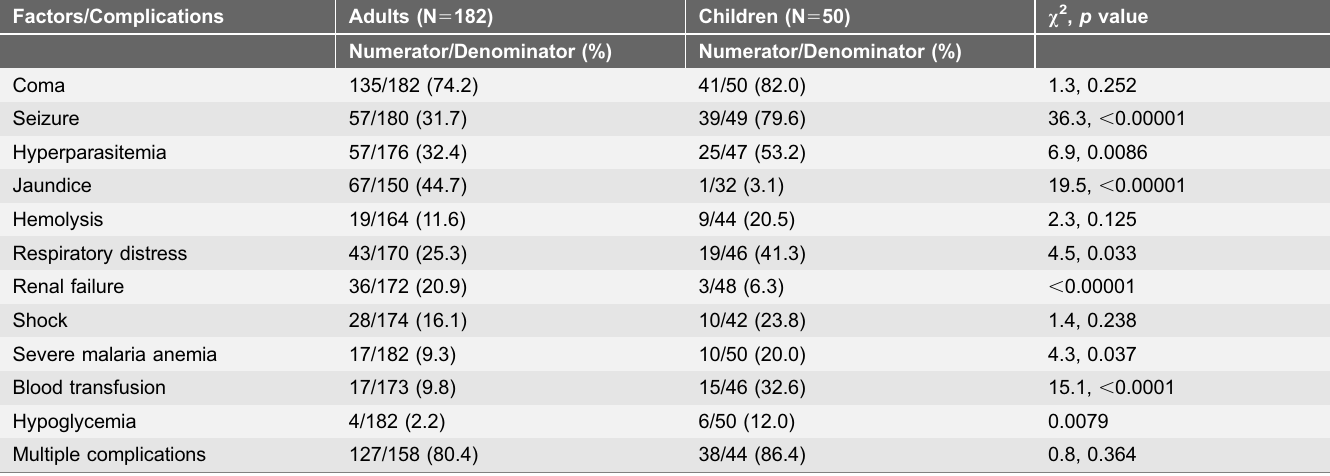
Table 5. Clinical comparison between enrolled adults and children diagnosed with complicated malaria (N 5 232) at Maharani Hospital Jagdalpur, Chhattisgarh,